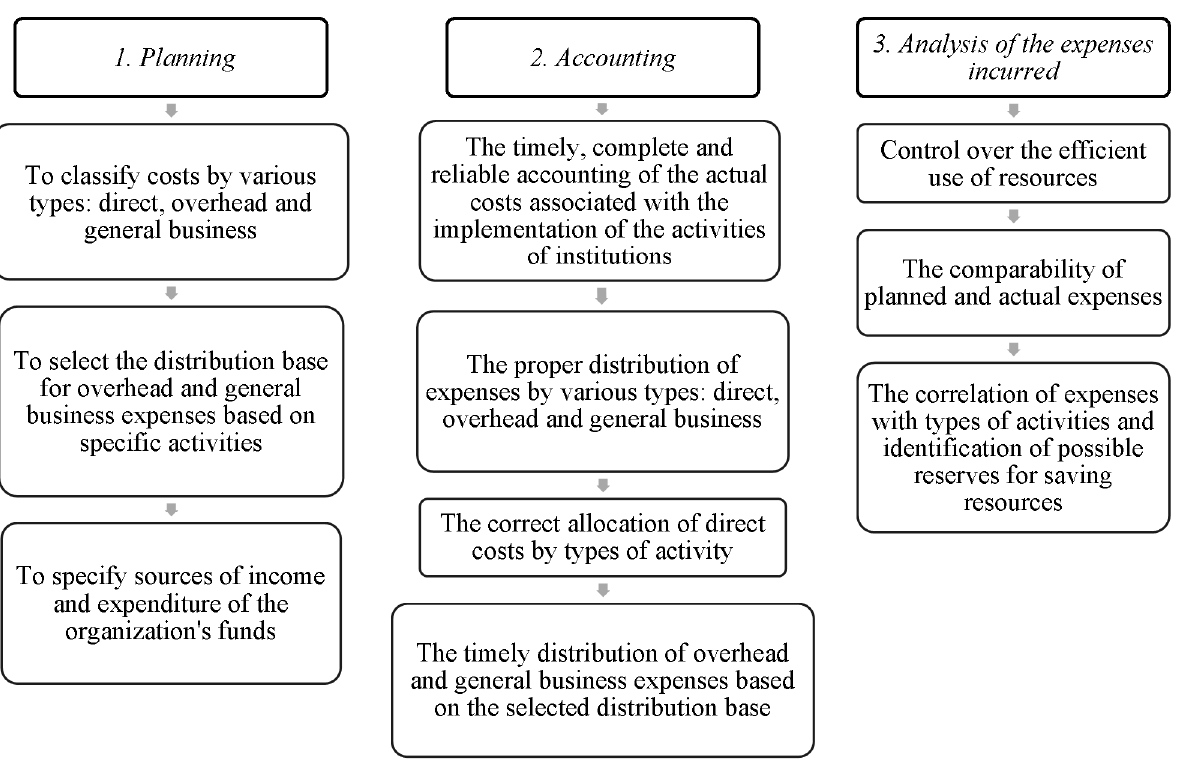
Figure 2. The mechanism for managing costs